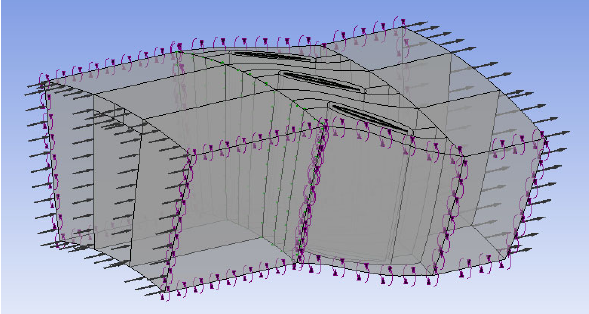
Figure 8. Computational domain of jet hole and rotor.